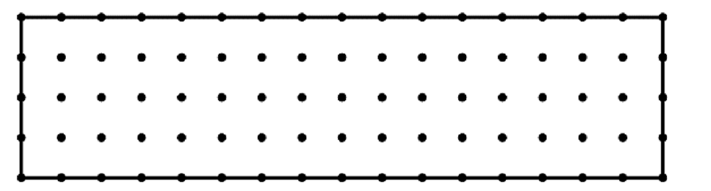
Figure 12. The nodal distribution for a cantilever beam.